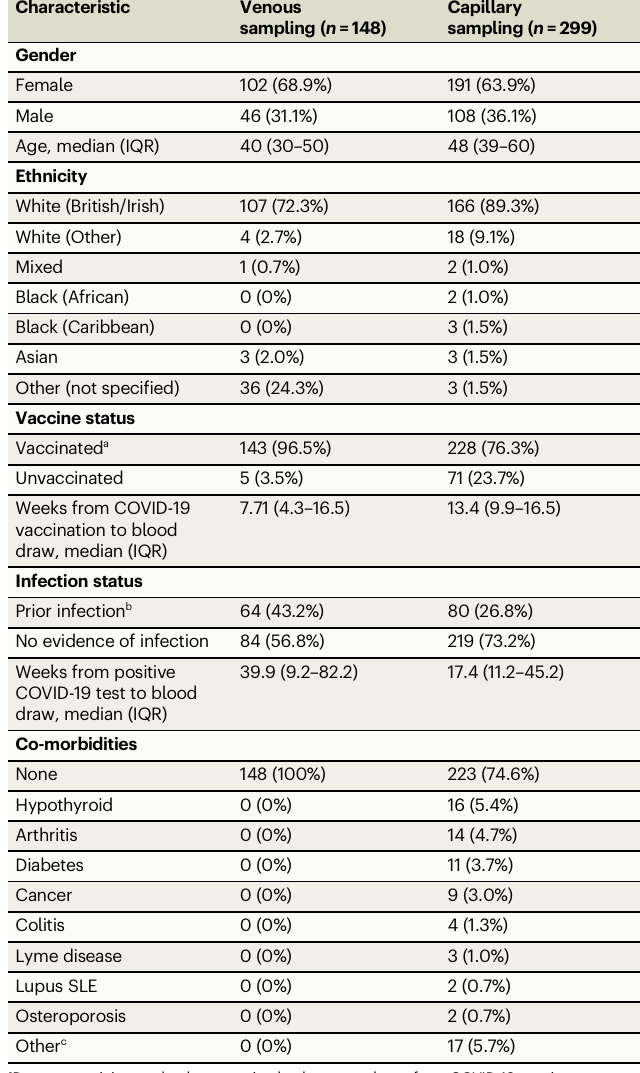
Table 1 | Participant characteristics